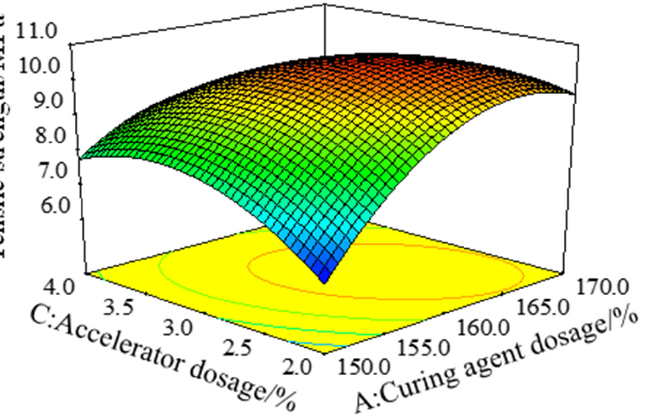
σ ) under the interaction of factors A and C . Figure 4. Response surface of the tensile strength model ( σ t ) under the interaction of factors A and C